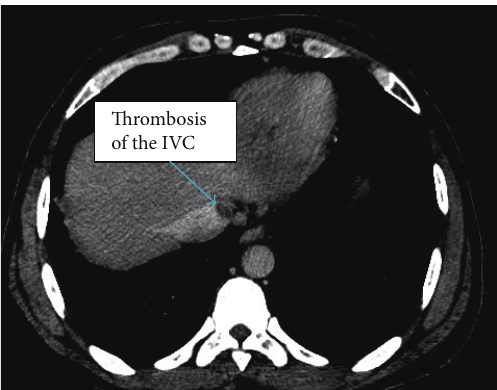
Figure 2: CT scan showing thrombosis of the hepatic portion of the